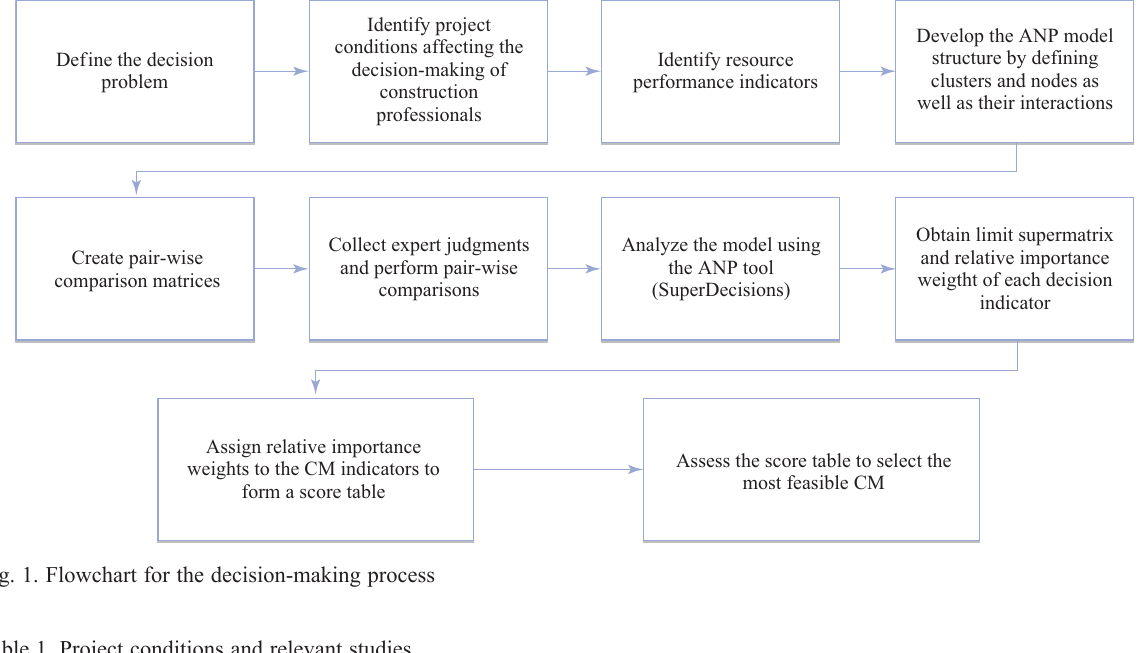
Table 1. Project conditions and relevant